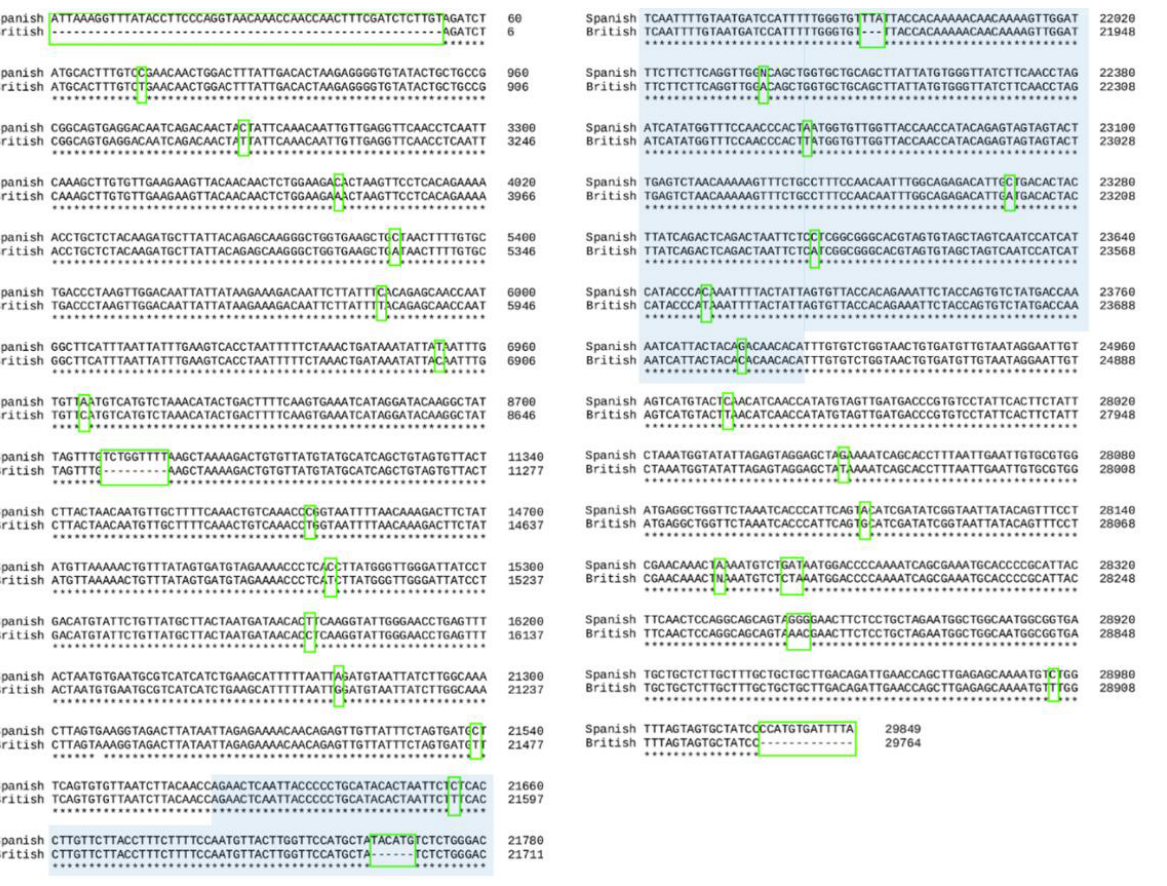
Figure 1. Complete genome alignment of Spanish and British variants. In light blue, spike gene alignment of the two variants. The differences between the two sequences are marked with a green box. A consensus line is shown below the nucleotide alignment of the two variants, with the following symbols indicating the degree of conservation observed for each compared pair: “ * ” (identical residues in all sequences), “ : ” (highly preserved column), “ . ” (weakly preserved col- umn).